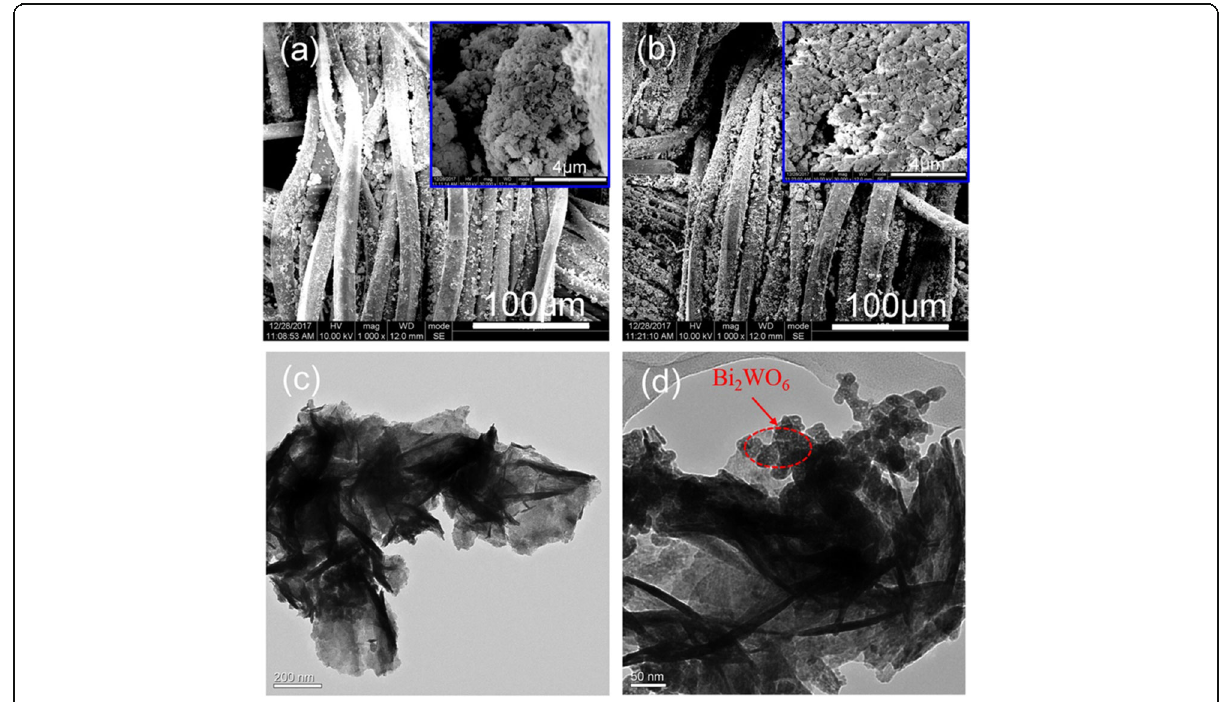
Fig. 2 SEM image of Bi 2 WO 6 ( a ) and Bi 2 WO 6 /GO deposited PET fibers ( b ); TEM images of the Bi 2 WO 6 /GO composites ( c , d